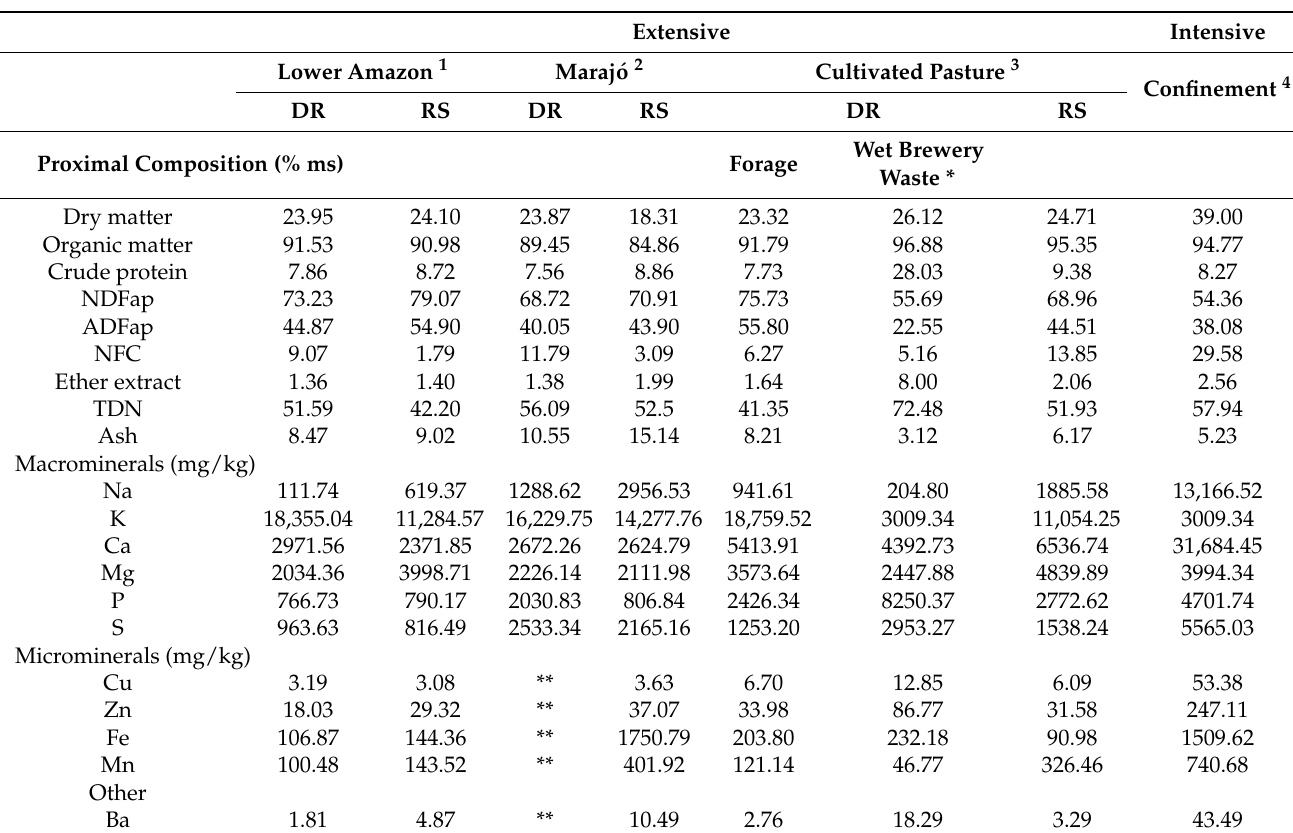
Table 1. Proximate and chemical composition of the diets of Murrah × Mediterranean buffaloes reared intensively and extensively in three types of ecosystems in the Amazon (Brazil) during the dry (DR) and rainy (RS) periods of the year ( n =